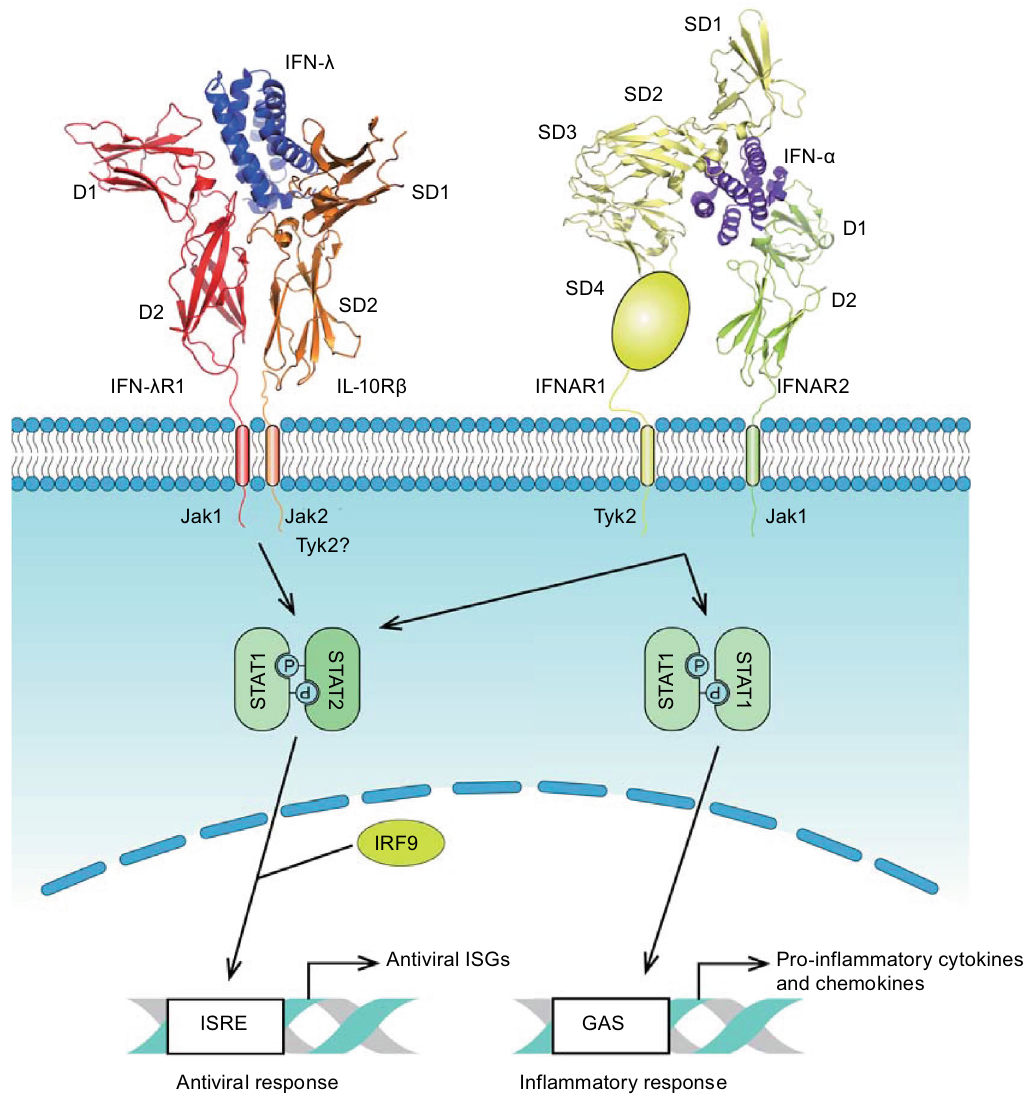
Figure 2. Different gene expression pattern triggered by type I and type III IFNs. Type III IFNs (IFN- λ 3, PDB ID: 5T5W) binding to their heterodimeric receptor composed of IFN λ R1 and IL-10R β triggers the formation of heterdimeric complex of STAT1 and STAT2 which translocates to the nucleus where it forms ternary complex with IRF9 and form IFN-stimulated gene factor 3 (IGF3). IGF3 binds to IFN-stimulated response elements (ISREs) and induces the expression of antiviral ISGs. Engagement of type I IFNs (IFN- α 2,